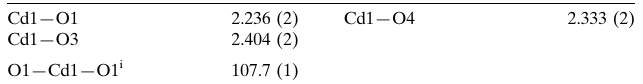
Selected geometric parameters (A˚ , (cid:1) ).